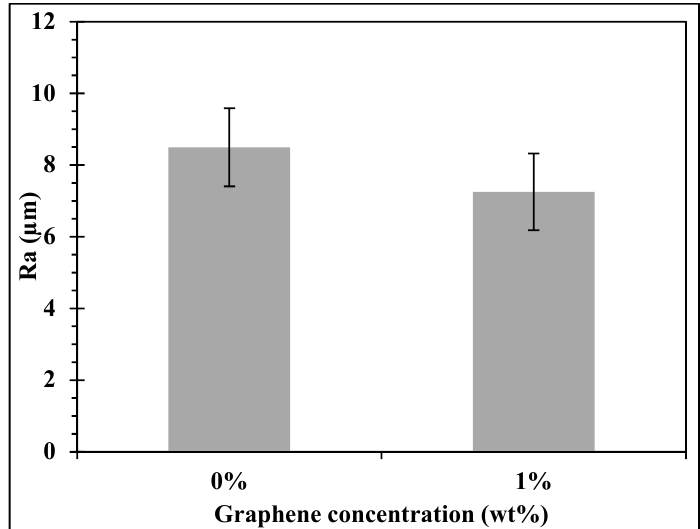
Figure 9. Surface roughness measurements.